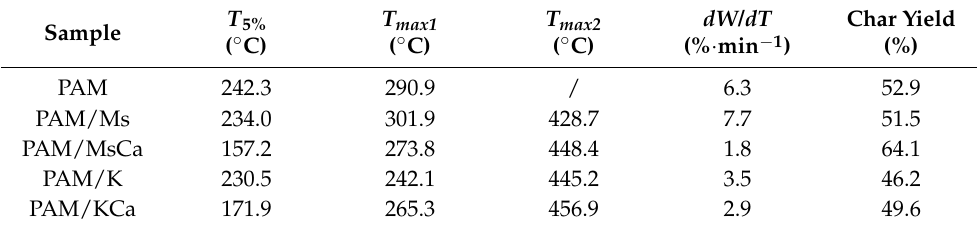
Figure 3. TG ( a ) and DTG curves ( b ) of the different PAM composite aerogels (N 2 atmosphere). Table 2. Thermal properties data of the different PAM composite aerogels (N 2 atmosphere).